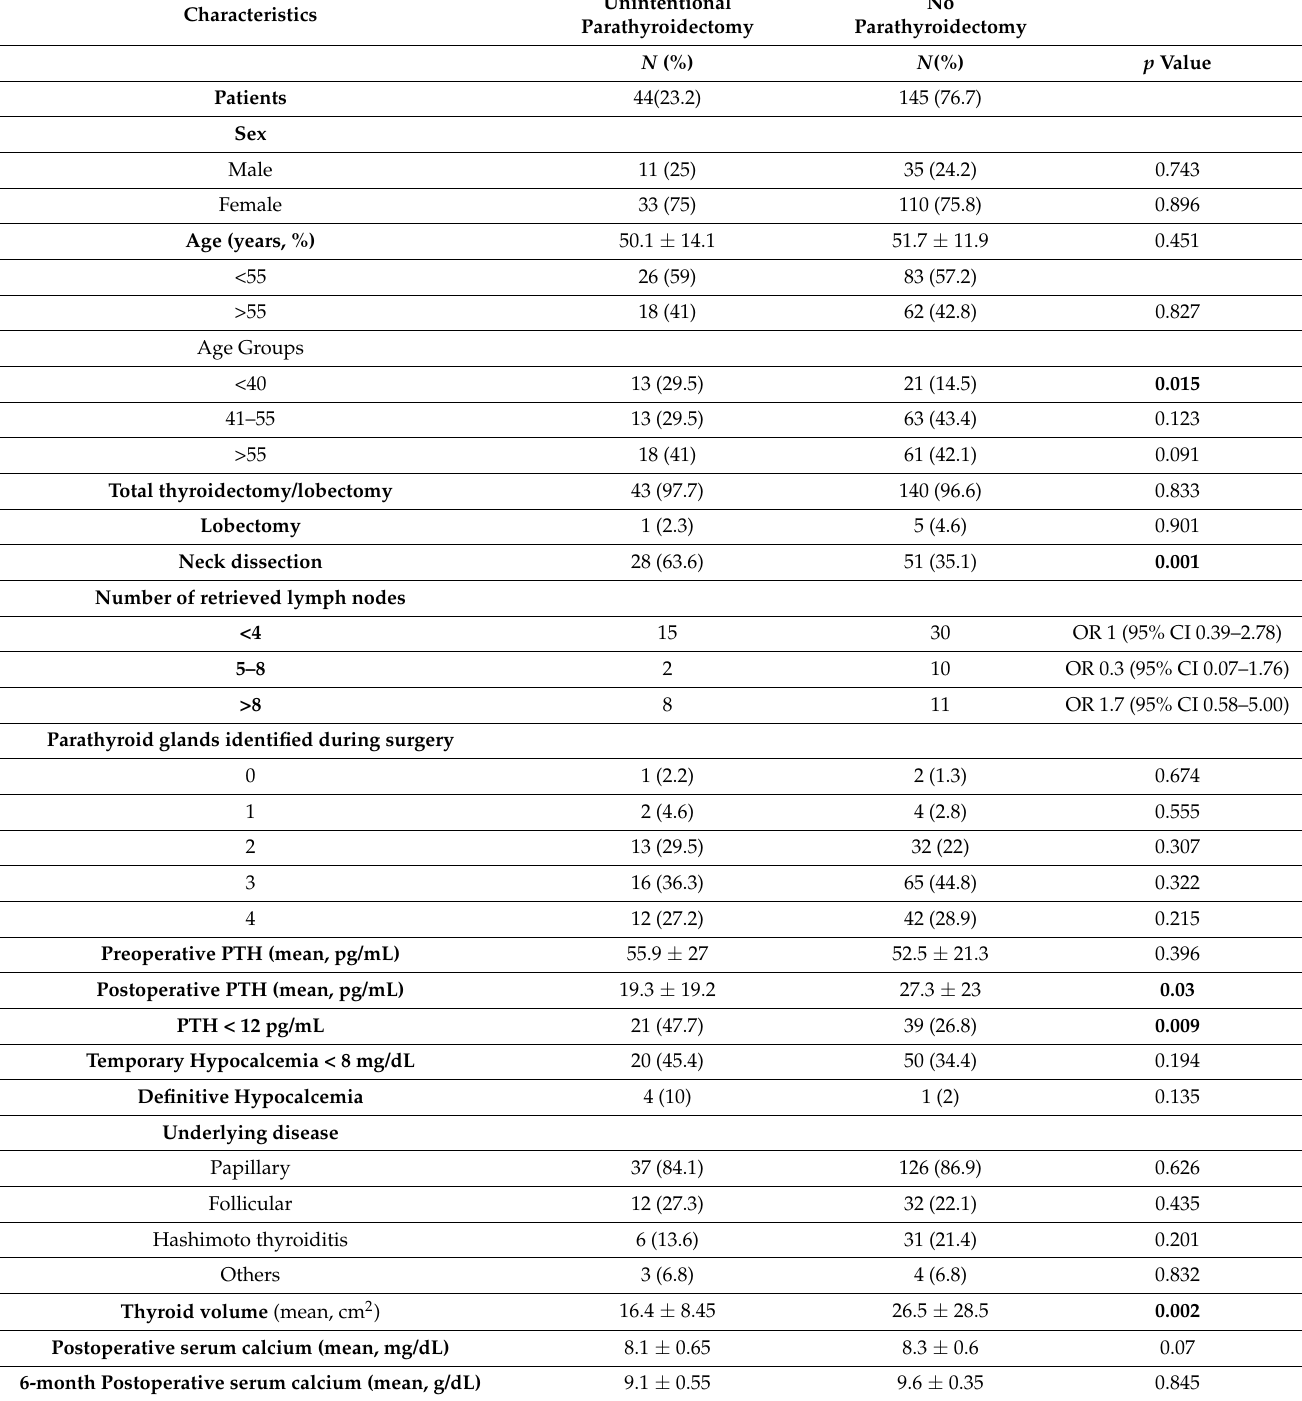
Table 4. Risk factors for un-intentional